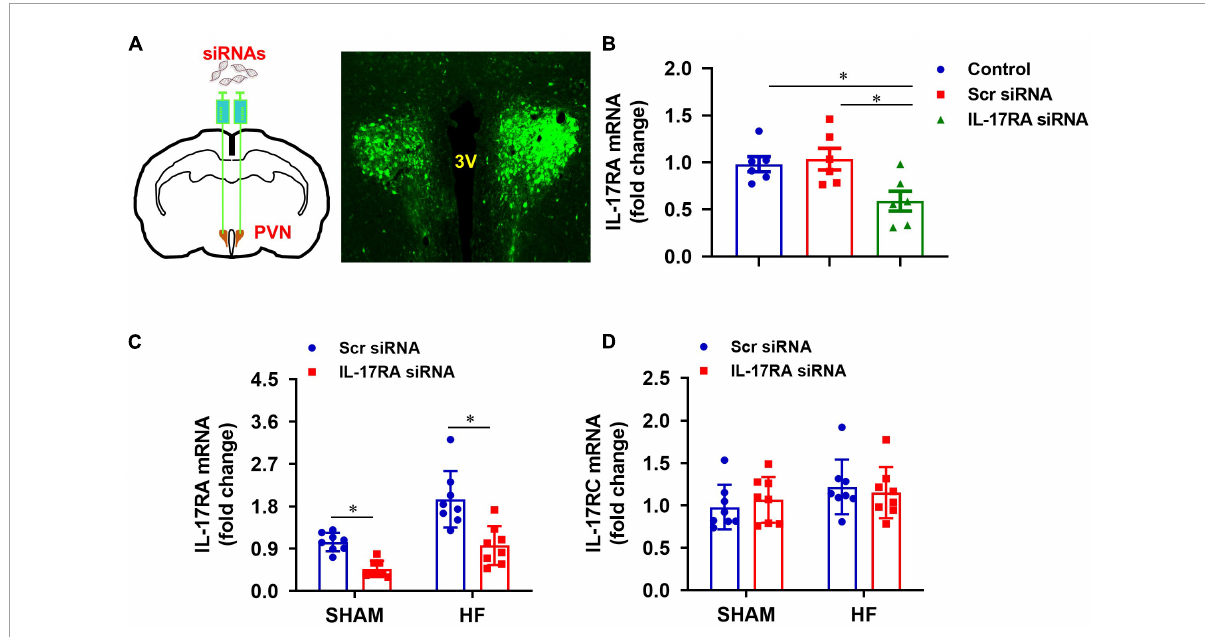
FIGURE3 (A) Schematic diagram showing bilateral PVN microinjection sites and GFP expression in the PVN, and (B) effect of bilateral PVN microinjection of IL-17RA siRNA on mRNA expression of IL-17A receptor IL-17RA in normal rats 1 week after bilateral PVN microinjections of IL-17RA siRNA AAV virus. (C,D) Effect of bilateral PVN microinjection of IL-17RA siRNA on mRNA expression of IL-17A receptors IL-17RA and IL-17RC in the PVN of SHAM and HF rats 4 weeks after CL. 3V: third cerebroventricle; Scr: scrambled siRNA. Values are mean ± SEM ( n = 6-8 for each group) and are expressed as a fold change compared to control or SHAM + Scr siRNA; * p <